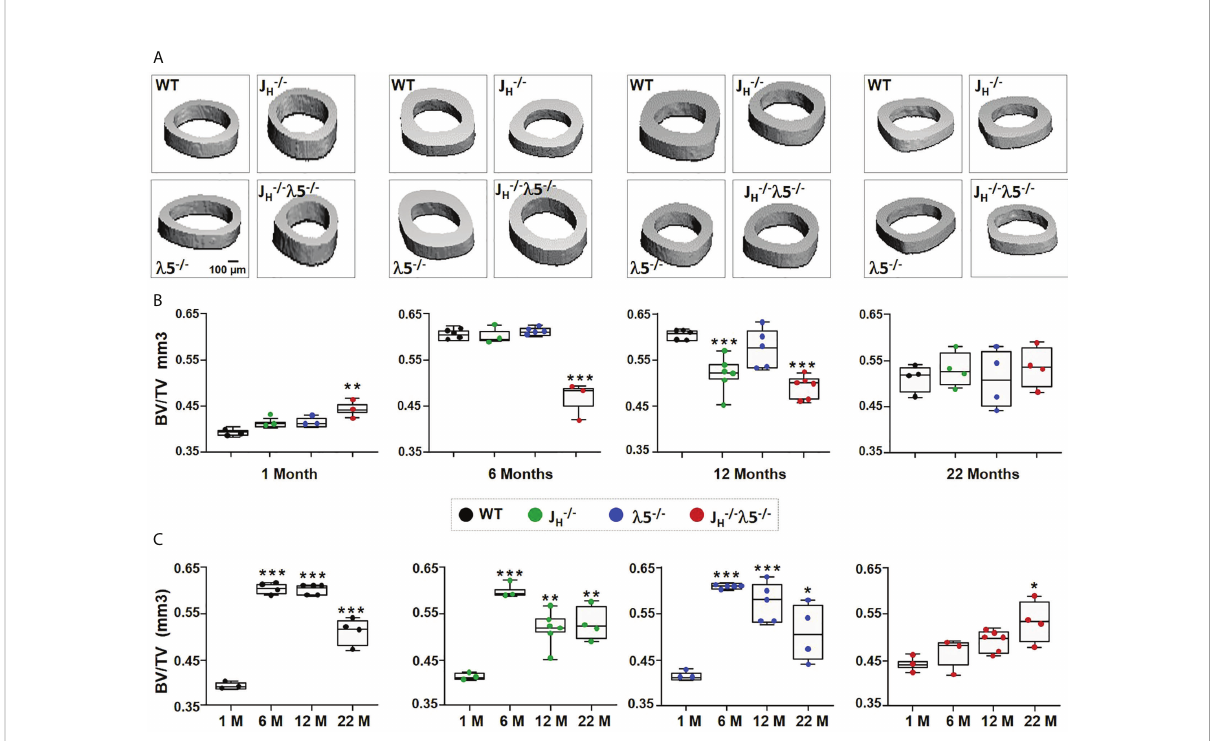
FIGURE 5 Age-related changes in cortical bone mass in the absence of l 5, post proB cells or both. (A) Representative 3D reconstruction of µCT of cortical bone from femurs of WT, J H-/- , l 5 -/- and J H-/- l 5 -/- mice at 1, 6, 12 and 22 months of age. (B) The box and whisker graph shows quanti fi cation of cortical BV/TV for indicated genotypes at one-, six-, and twelve- and twenty-two-months of age. (C) The relative ratio of cortical BV/TV of WT, J H-/- , l 5 -/- and J H-/- l 5 -/- mice at the indicated ages. Data were obtained from n=3-6 mice per group. Statistical signi fi cance was calculated by ANOVA. *p<0.05, **p<0.01, ***p<0.001. Scale bar: